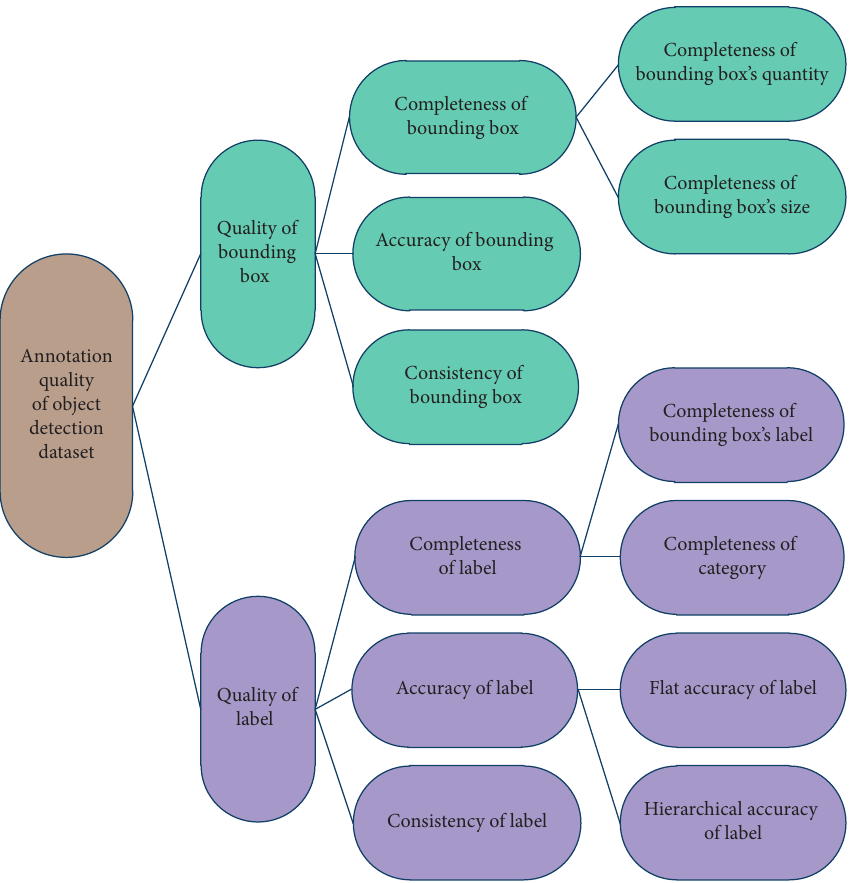
Figure 1: Annotation quality evaluation